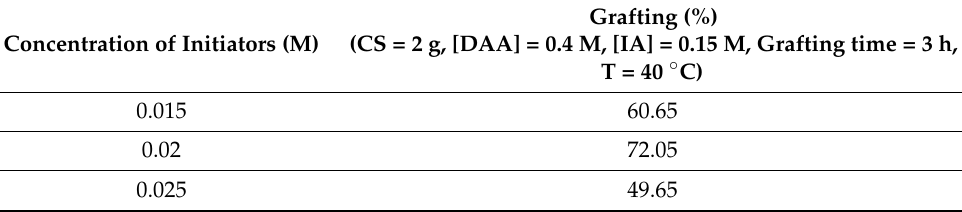
Table 5. Effect of initiator concentration on the percentage of graft.